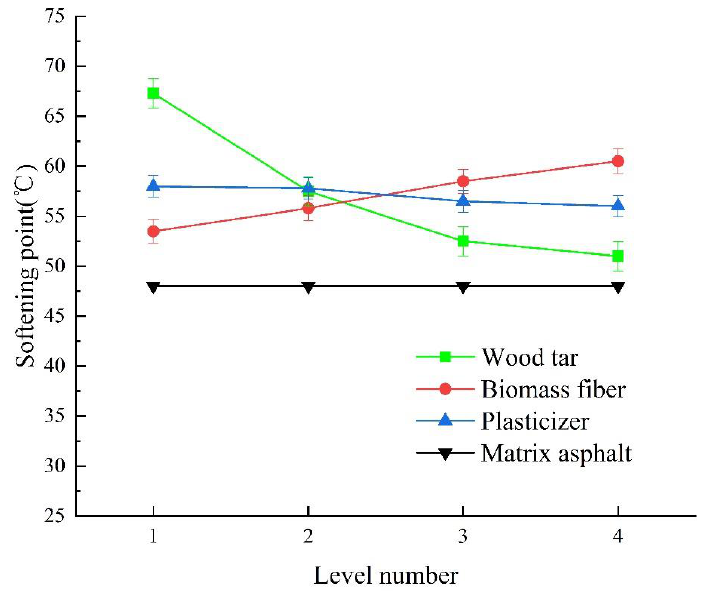
Figure 6. Change rule of softening point of wood tar-based rejuvenated asphalt under different factors and levels.